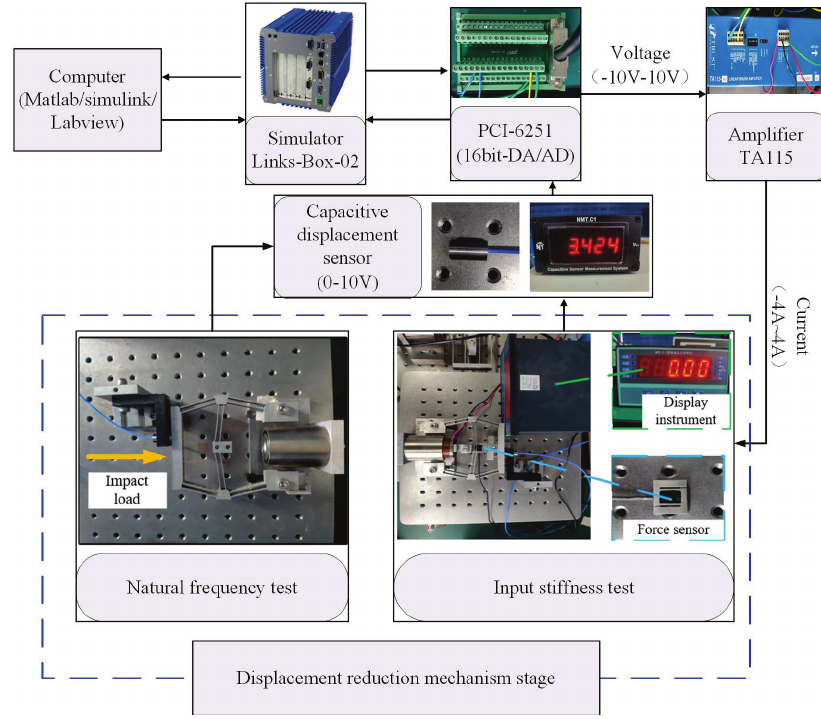
Figure 7. Displacement reduction mechanism and experimental test system.